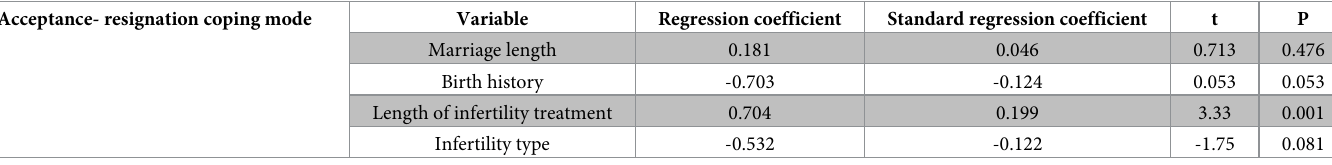
Table 6. Multivariate analysis of the acceptance-resignation coping mode among the patients treated with IVF-ET. Acceptance- resignation coping